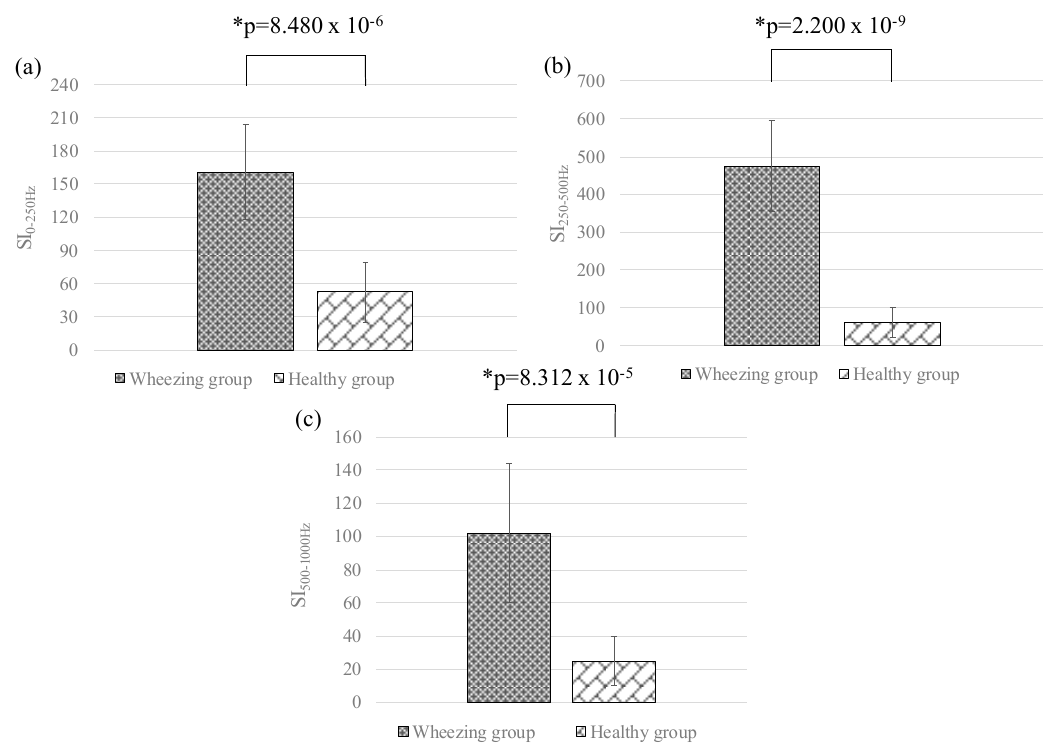
Figure 7. Means and standard deviations of ( a ) SI 0Hz-250Hz ; ( b ) SI 250Hz-500Hz ; and ( c ) SI 500Hz-1000Hz for different groups. Here, * denotes significant difference.